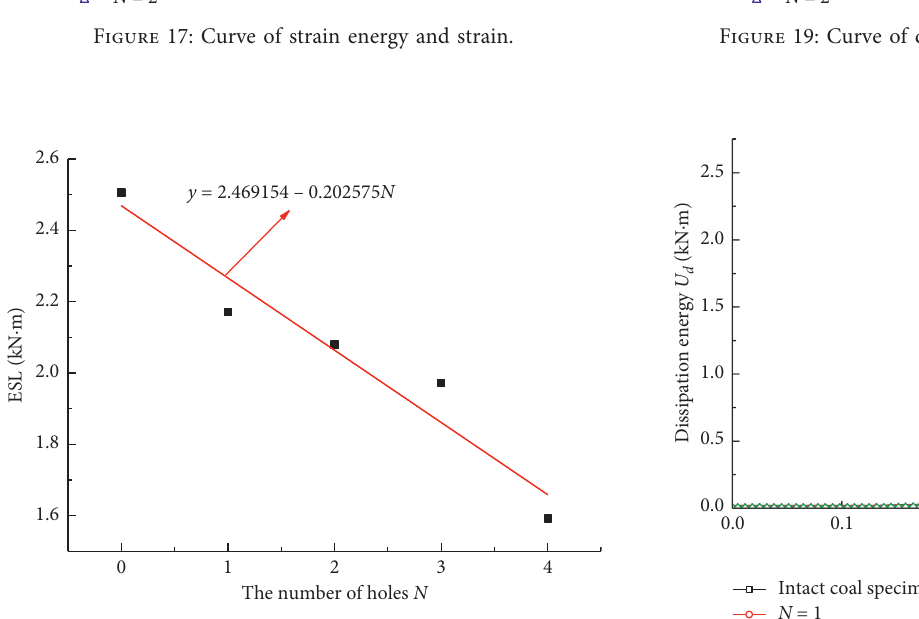
Figure 18: Relationship between the ESL and hole number.